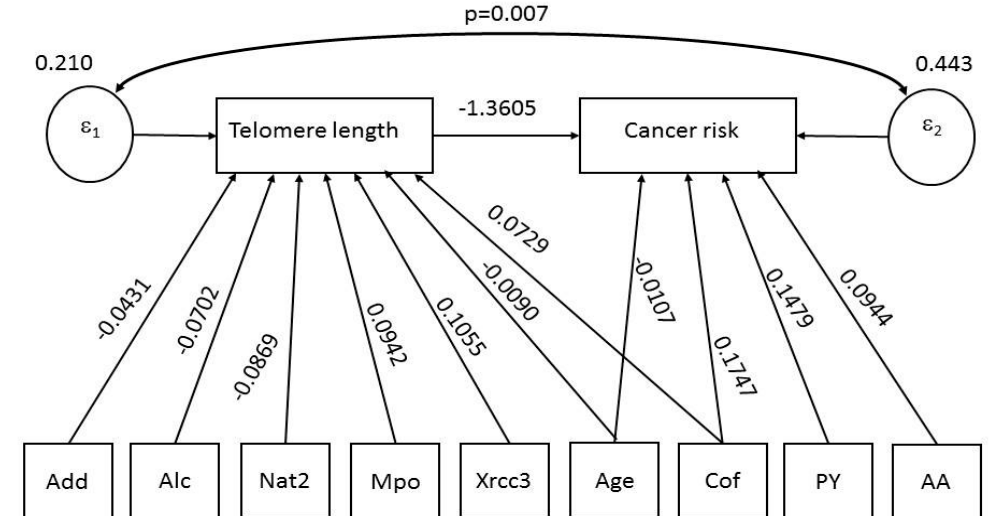
Figure 1. Path diagram of results shown in Table 2: variables (square boxes); causal flow (arrows); and paths (arrowed route); error terms for each equation (circles) and correlation between errors (curved path) with the corresponding p-value. The estimated beta coefficients appeared along the paths. Figure legend: Age = Age at diagnosis; Mpo = Mieloperoxidase; PY = Pack-years; Add = DNA adducts (ln); Cof = Coffee, (cumulative); AA = Aromatic amines (cumulative); Alc = Alcohol (cumulative); XRCC3 = X-ray repair cross-complementing protein 3; Nat2 = N -acetyl transferase 2.